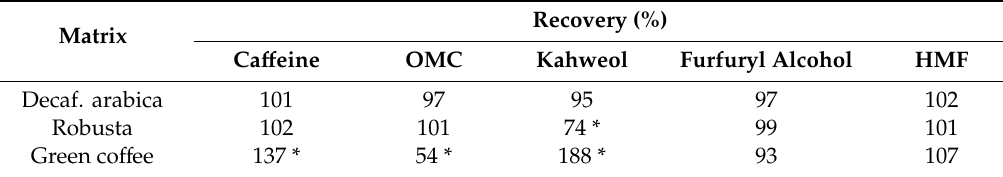
Table 6. Recovery of co ff ee constituents from di ff erent